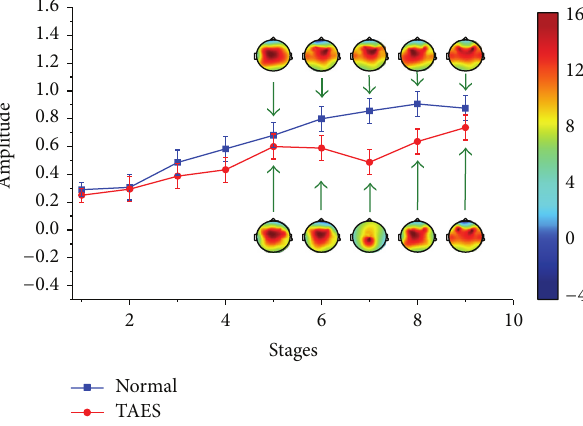
Figure 3: Relative power spectrum (mean ± S.D.) of 𝜃 subband for 9 stages of driving.